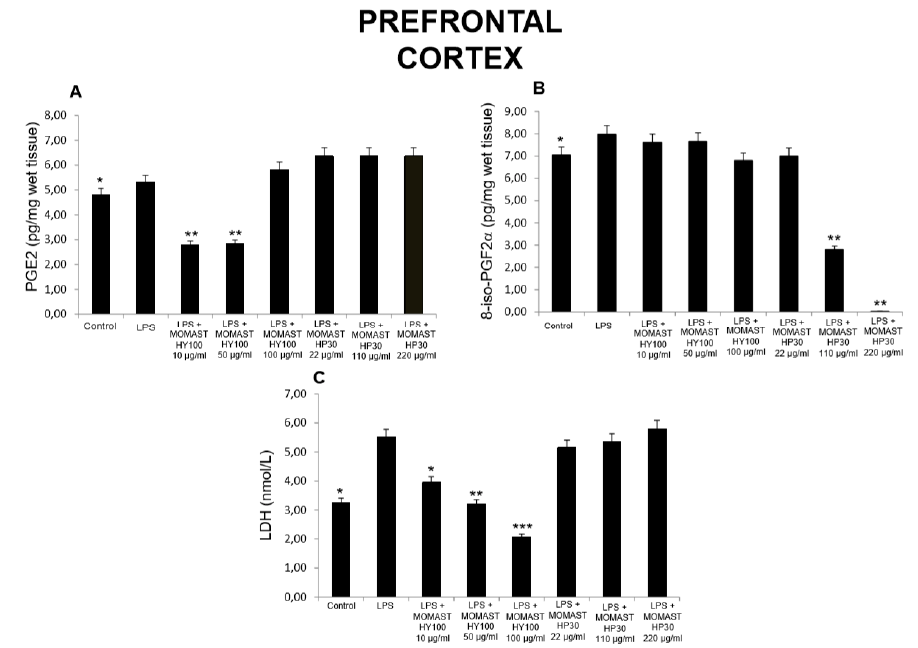
Figure 1. Effects of MOMAST( ® ) HY100 (10, 50, and 100 µg/mL) and MOMAST( ® ) HP30 (22, 110, and 220 µg/mL) on ( A ) PGE 2 levels (pg/mg wet tissue), ( B ) 8-iso-prostaglandin F 2 α (8-iso-PGF 2 α ) levels, and ( C ) lactate dehydrogenase (LDH) activity (nmol/L) in rat prefrontal cortex specimens. Data were reported as means ± SEM. ANOVA, p < 0.01; post-hoc test, * p < 0.05, ** p < 0.01, *** p < 0.001 vs. lipopolysaccharide (LPS)-treated group.